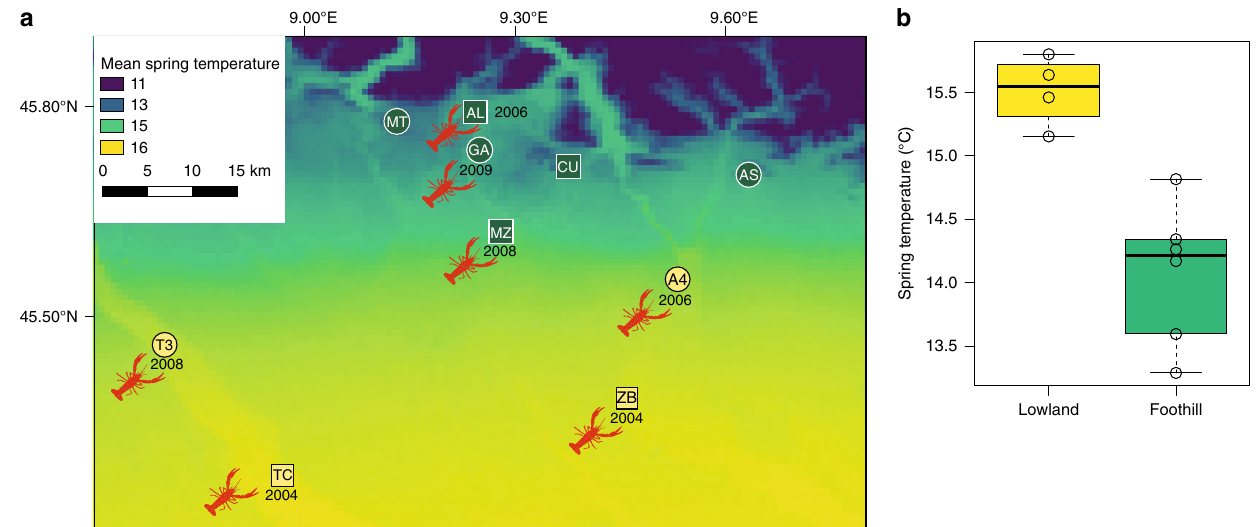
Fig. 1 Climatic regime and invasion status in the study area. a Location of study populations. Squares represent frog populations analysed before the cray fi sh invasion (2003), whereas circles indicate populations added for analyses performed after the cray fi sh invasion (2017). Invaded populations are labelled by a cray fi sh and, for each of them, we report the year of fi rst detection of the cray fi sh. Foothill populations are in dark green; lowland populations are in pale yellow. The background map also shows average spring temperature, from warmer lowlands to colder foothills. b Boxplot representing differences in spring temperature between the six foothill and the four lowland breeding sites (values of mean spring temperature, n = 10 localities; two- tailed student ’ s t test: t 7 = 3.97; P = 0.005). Box limits represent the fi rst and the third quartiles, the central line is the median, the whiskers represent the extreme values. Source data are provided as a Source data fi le.